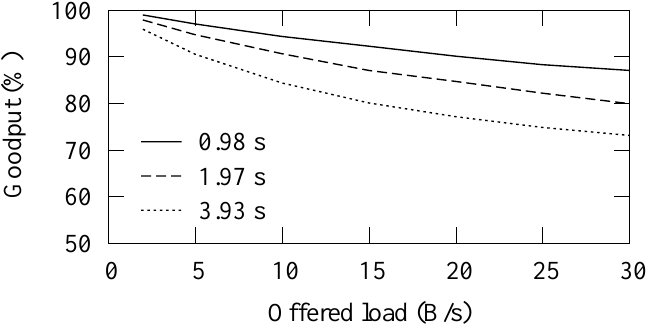
Figure 11. Goodput with different access cycle lengths in ZigBee. Duty cycle and through- put are the same on each